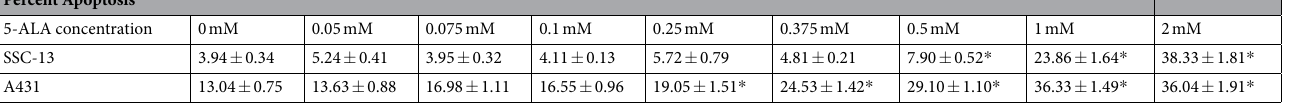
Table 1. Percent apoptosis of 5-ALA treated samples at variable concentrations. Abbreviations: 5-ALA – 5-aminolevulinic acid. P < 0.05 denoted by asterisk ( * ).